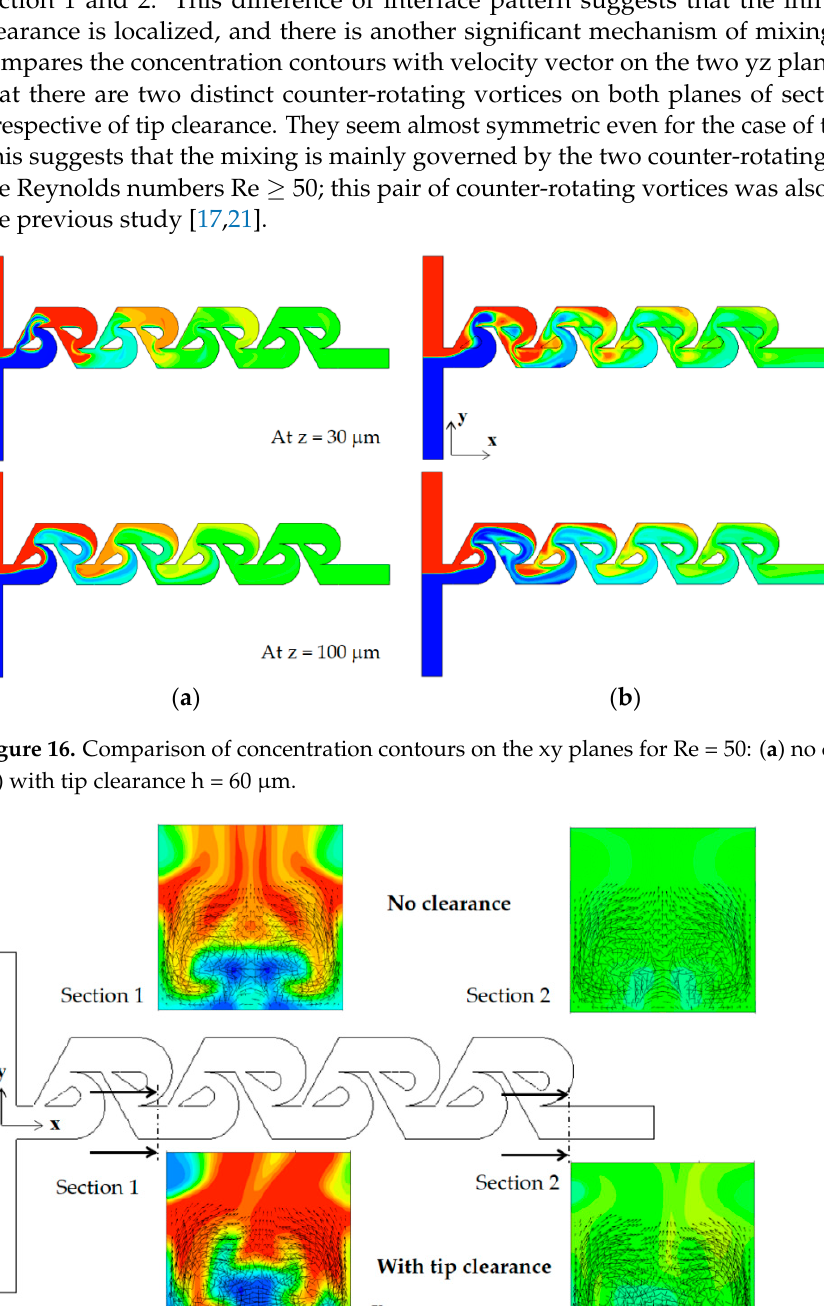
13 of 17 Figure 15. Concentration contours with velocity vector on the yz planes for Re = 10. As the Reynolds number increases further, the vortex flow formed in the vortex zone of each Tesla mixing unit develops into a pair of strong counter-rotating vortices. They are separated distinctly and become stronger. Figure 16 compares the concentration con-